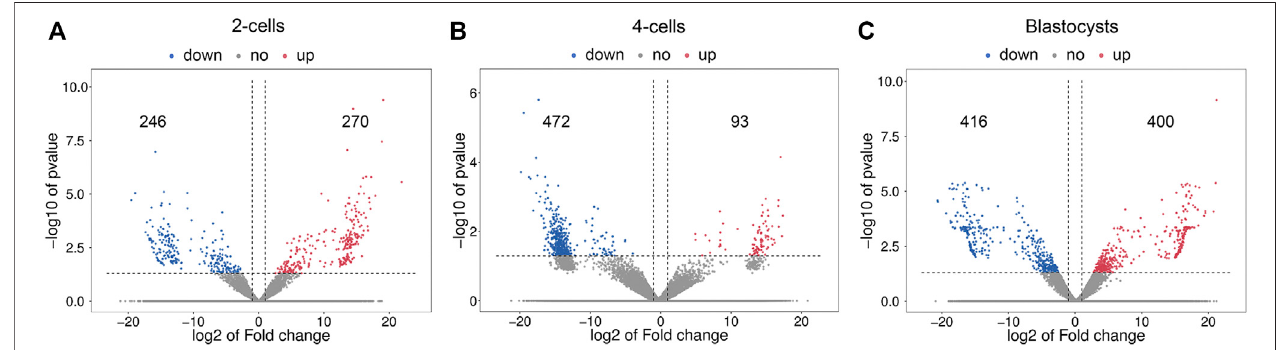
FIGURE3| Volcanoplotsofdifferentiallyexpressed lncRNAsin (A) 2-cells, (B) 4-cellsand (C) blastocystsderivedfromvitri fi edporcineclonedzygotes.Redpoints indicate signi fi cant up-regulated lncRNAs, blue points indicate signi fi cant down-regulated lncRNAs, while grey points indicate lncRNAs without differences. The X-axis represents the log2 fold change, Y-axis means the − log10 ( p -value).